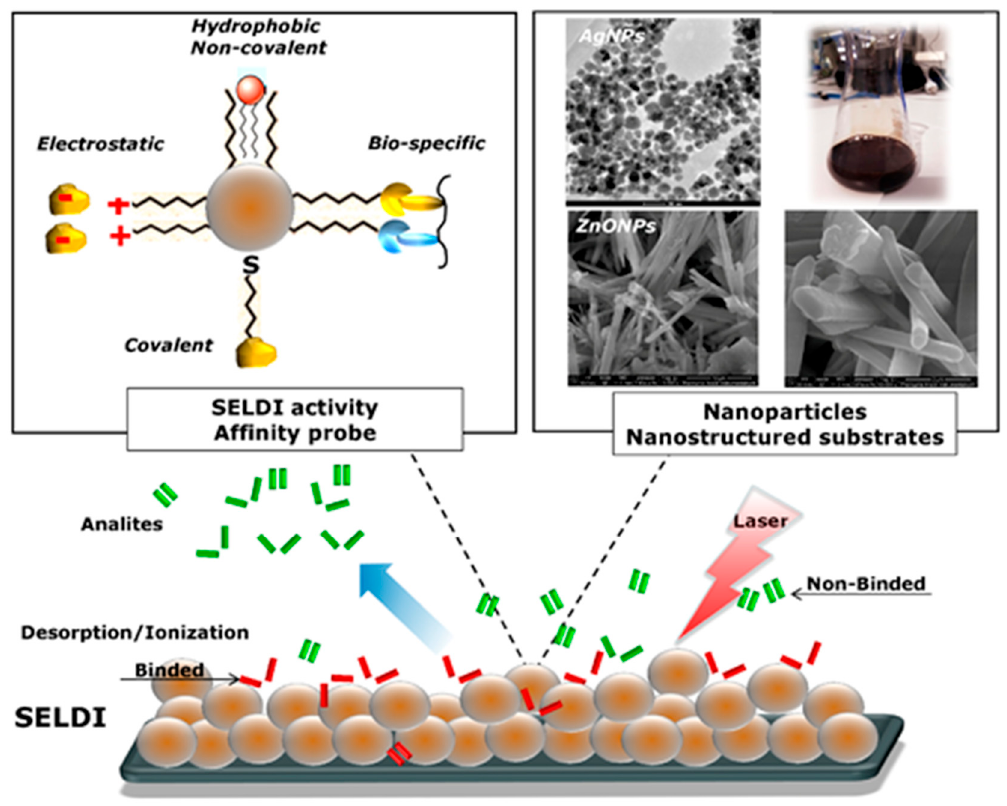
Figure 3. Principle of surface-enhanced laser desorption/ionization approach.